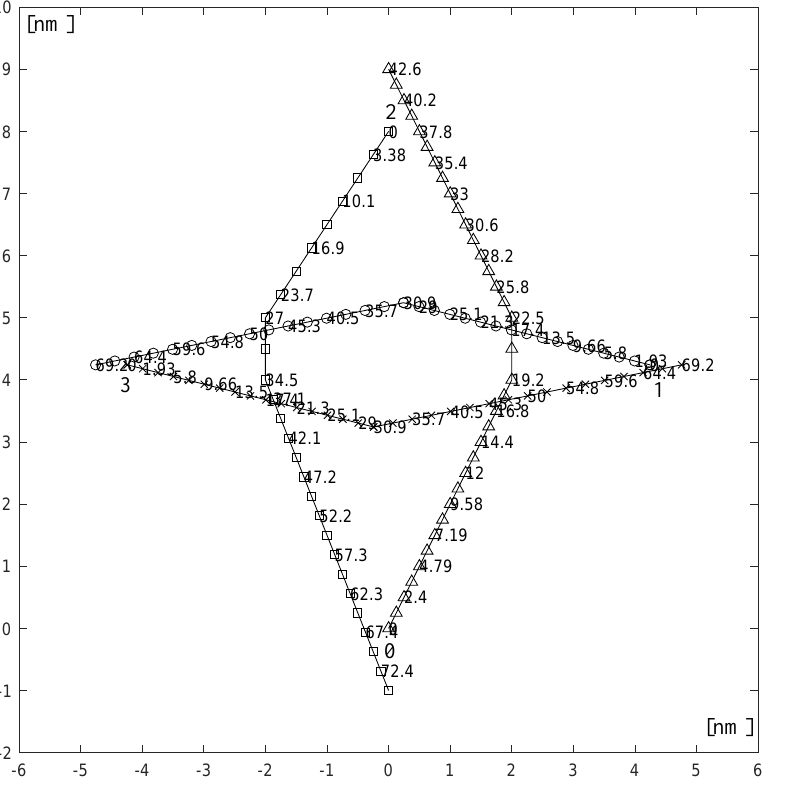
Figure 9. Solution of test case 4. Table 12. Output data of test case 3.